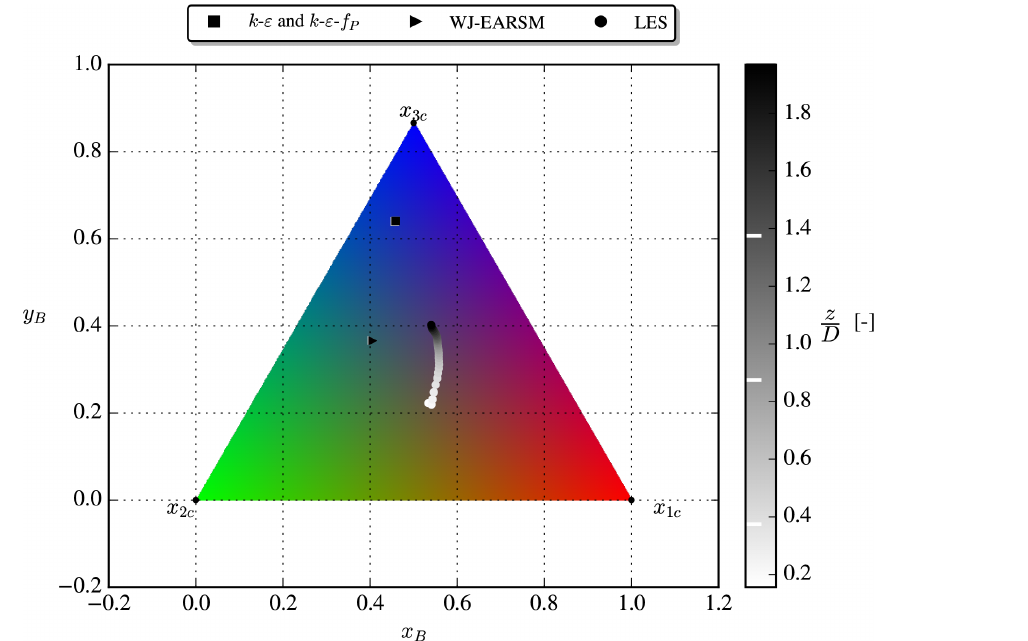
Figure 13. RGB-colored barycentric triangle, with RANS/LES inflow data shaded by height; white lines at right mark ( z ref − R ), z ref , and ( z ref + R ), respectively.